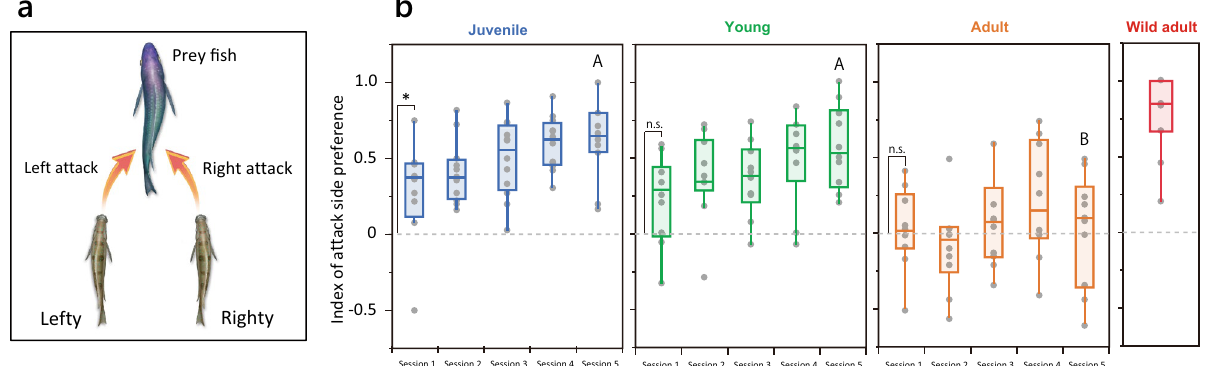
Figure 2. Attack side preference in Perissodus microlepis . ( a ) Diagram representing the link between attack side for scale-eating and mouth asymmetry of the predators. ( b ) Preference of attacks from the dominant side in Sessions 1–5. The initial attack side preference was tested in Session 1 using a one-sample Wilcoxon signed- rank test for deviation from chance (0.5). * p < 0.05. “A” and “B” represent significant differences in pairwise comparisons (Tukey HSD test, p < 0.001). The value for wild adult P. microlepis is shown on the extreme right (Takeuchi et al.